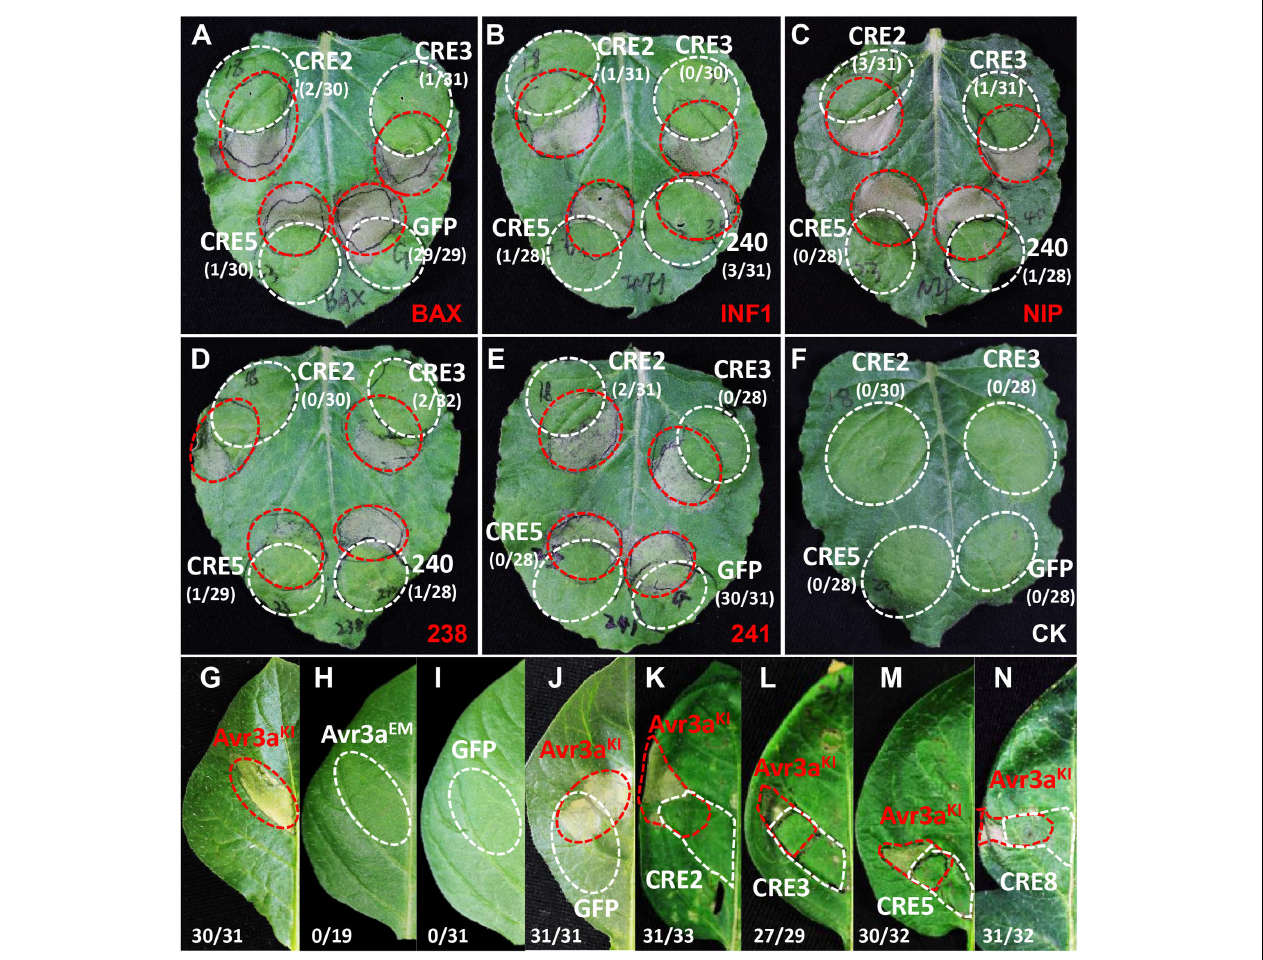
FIGURE 4 | Plant defense suppression activities of selected P . infestans RXLR effector genes. Candidate RXLR effector genes that were highly expressed at the early stage of plant infection were selected and A . tumefaciens -mediated transient expression assays were performed on N . benthamiana (A–F) and host potato (G–N) . In N . benthamiana , all examined RXLR effector genes suppressed HR mediated by a range of elicitors including: (A) BAX; (B) the P . infestans PAMP elicitor INF1; (C) NIP; the P . sojae RXLR effectors Avh238 (D,E) Avh241. The red circle indicates the area infiltrated with A . tumefaciens cells carrying elicitor constructs. The white circle indicates A . tumefaciens cells carrying the RXLR effector gene CRE2 (PITG_04196), CRE3 (PITG_05750), and CRE5 (PITG_06308), the negative control GFP (A,E) , and the positive control Avh240 (B–D) . In S . tuberosum , the P . infestans RXLR effector Avr3a KI induces HR in the differential host line ‘Ma R3, ’ which was suppressed by transient expression of RXLR effector genes (K) CRE2 , (L) CRE3 , (M) CRE5 , and (N) CRE8 (PITG_09160); (G) the positive control Avr3a KI , and (H–J) the negative control Avr3a EM , GFP, and Avr3a KI plus GFP. The numbers show the ratio of infiltrated sites that developed cell death versus the total number of infiltrated